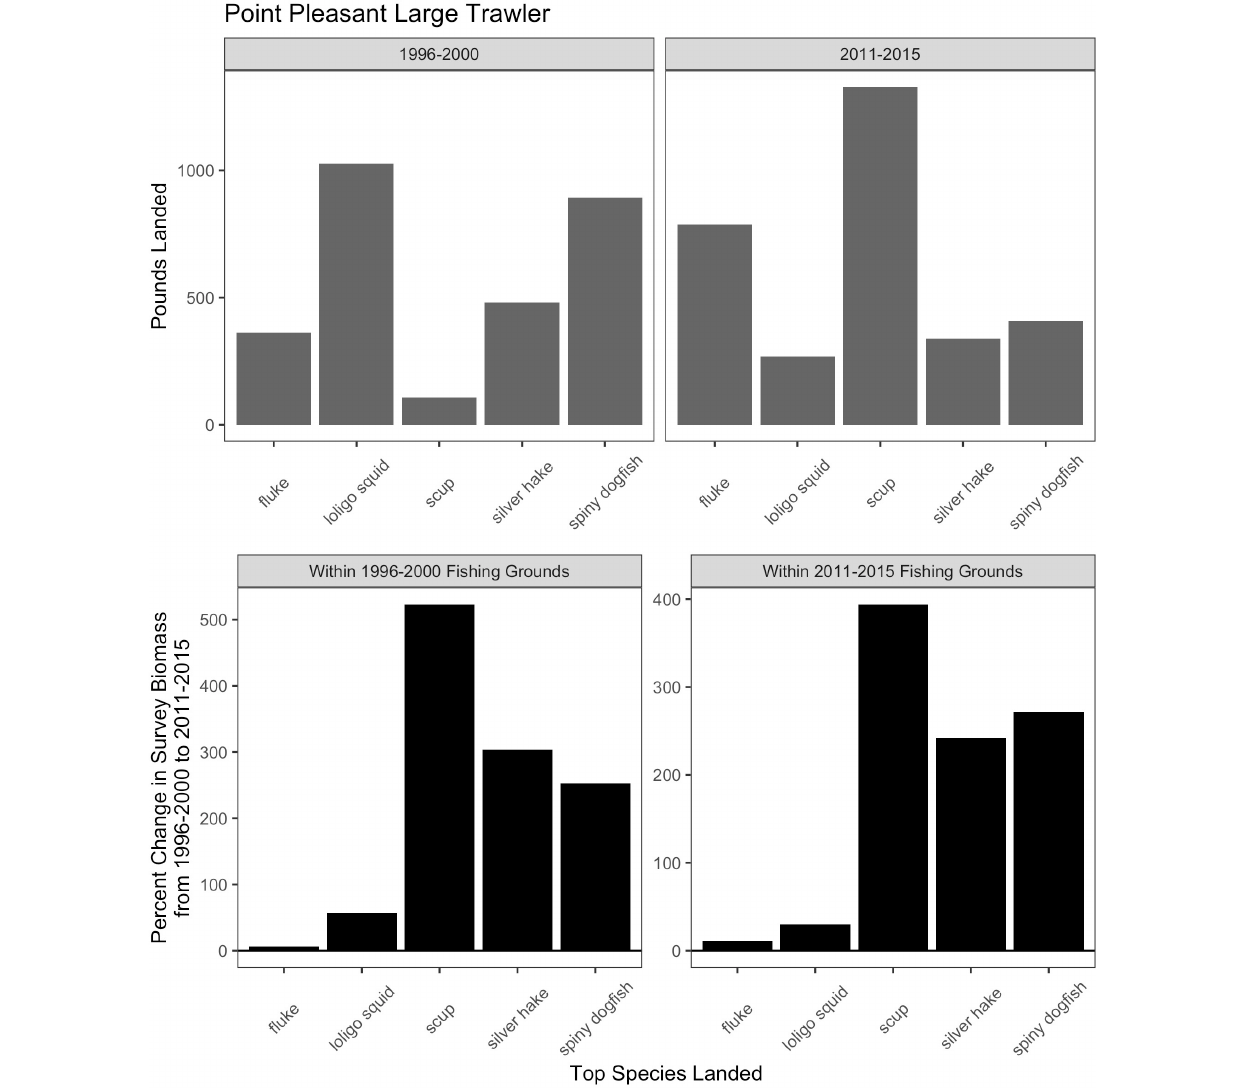
FIGURE 9 | Match and mismatch between changes in biomass and fishery catch in Point Pleasant, New Jersey large trawlers. (Top) The landed volume (lbs) for the top 5 species in the baseline (1996–2000; left) and recent period (2011–2015; right). (Bottom) The percent change in survey biomass between 1996–2000 and 2011–2015 observed within the fishing grounds fished during the baseline period (left) and in the recent period (right). Species scientific names: fluke = Paralichthys dentatus , loligo squid = Loligo pealeii , scup = Stenotomus chrysops , Silver hake = Merluccius bilinearis, and spiny dogfish = Squalus acanthias.